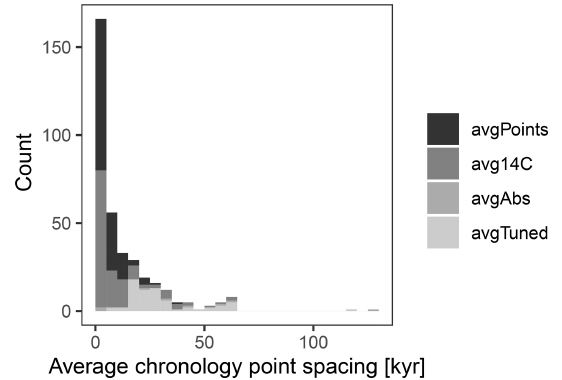
Figure 6. Average temporal spacing between chronology tie points (avgPoints). Tie points are also split into 14 C, absolute (tephra or palaeomagnetics) and tuned. The majority of the time series in the synthesis has a spacing of chronology tie points that is below 5000 years.